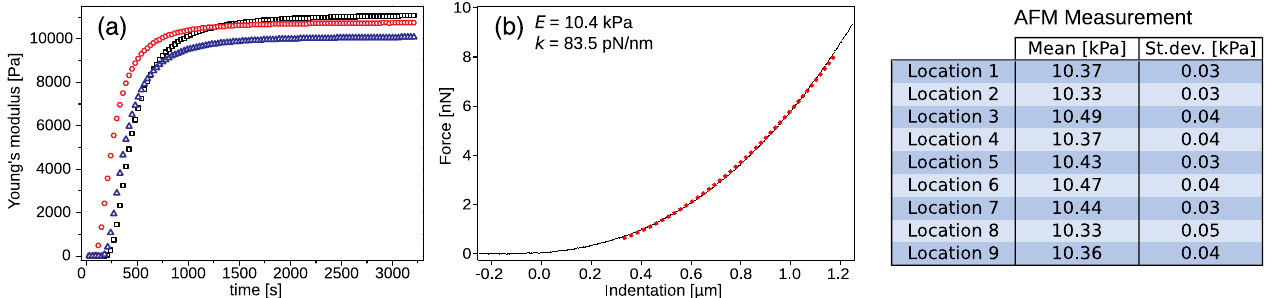
FIG. 5. Characterization of the gel stiffness. (a) Bulk rheology measurement of Young ’ s elastic modulus E over time. Plateau values are 11.1 kPa (black squares), 10.7 kPa (red circles), and 10.1 kPa (blue triangles), which yields an average value of E ¼ 10 . 6 (cid:2) 0 . 3 kPa. (b) AFM measurement of the force distance curve (black dots) and the fitted Hertz model (red dashed line) giving Young ’ s modulus E of the gels as 10.4 kPa. The table shows the mean values of the fitted Young ’ s moduli E of ten measurements at each of the nine locations on the PA